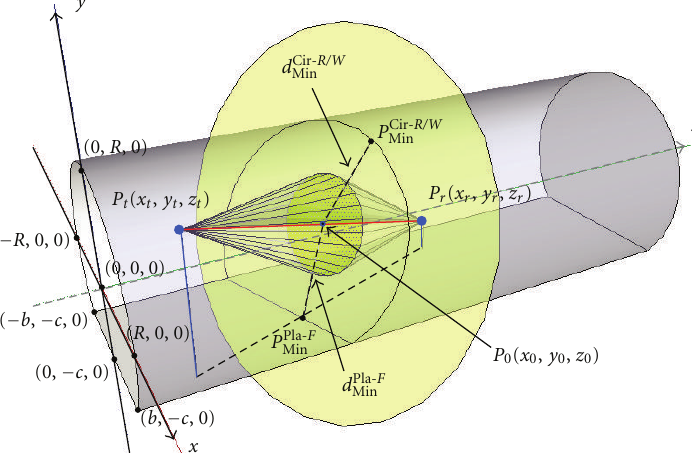
Figure 6: Detailed schematic diagram of the propagation inside the arched tunnel “Type II” with the first Fresnel zone